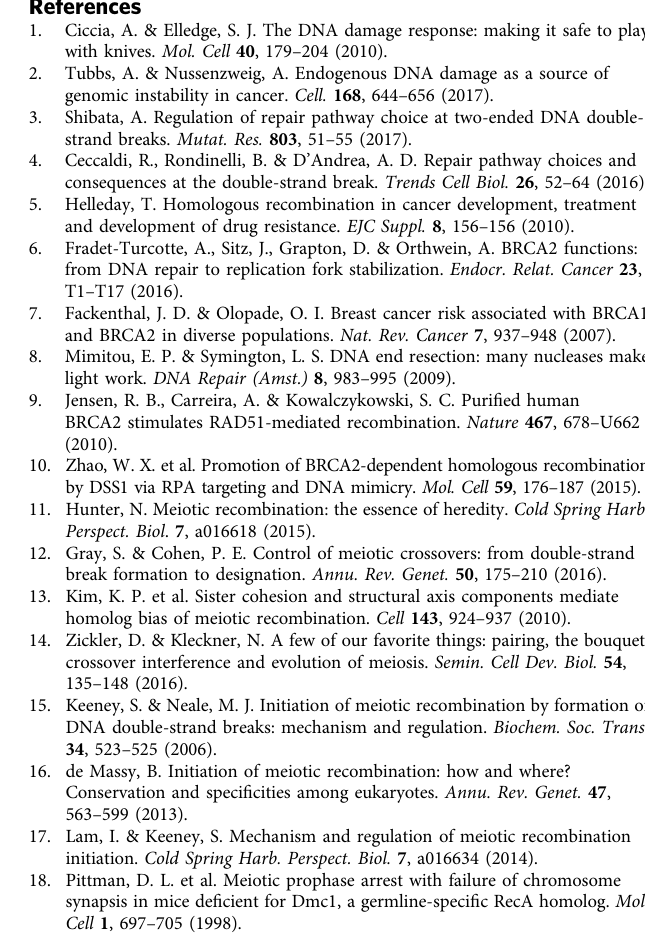
Fig. 6 BRCA2 localization during meiotic prophase I. a , b Wild-type (WT) spermatocytes expressing GFP-BRCA2-C ( a ) or GFP-BRCA2-MBD ( b ) stained with the indicated antibodies and 4,6-diamidino-2-phenylindole (DAPI). c WT zygotene spermatocytes expressing GFP-BRCA2-MBD stained with the indicated antibodies and DAPI. The quanti fi cation of co-localization was performed using nine zygotene cells pooled from three electroporated mice. The axis-associated foci were counted. d , e Zygotene spermatocytes from WT, Meilb2 − ⁄ − , and Dmc1 − ⁄ − males expressing GFP-BRCA2-C ( d ) or GFP-BRCA2- MBD ( e ) stained with the indicated antibodies and DAPI. The graph shows the frequency of the green fl uorescent protein (GFP)-positive zygotene spermatocytes with punctate GFP foci. The mean values of three independent experiments from three different electroporated mice are shown (GFP- BRCA2-C: 63 cells in WT, 57 cells in Meilb2 − ⁄ − , and 85 cells in Dmc1 − ⁄ − . GFP-BRCA2-MBD: 51 cells in WT, 53 cells in Meilb2 − ⁄ − , and 76 cells in Dmc1 − ⁄ − ). Error bars show SD. f Schematic of the hierarchical loading of meiotic double-strand break (DSB)-associating proteins. After DSB formation by SPO11, the double-strand DNA is resected into single-strand DNA (ssDNA). RPA is loaded onto the ssDNA, which is epistatic to the localization of MEILB2. MEILB2 is then recruited to the DSBs, likely through binding to RPA or SPATA22-MEIOB, and this in turn recruits BRCA2 through the MEILB2 – MEILB2-binding domain (MBD) interaction. BRCA2 then facilitates the loading of the RAD51 and DMC1 recombinases onto the ssDNA, resulting in the formation of a nucleoprotein fi lament that promotes DNA strand invasion. Lep leptotene, Zyg zygotene, Pac pachytene, Dip diplotene. All analyses used two-tailed t tests. N.S. not signi fi cant. **** p < 0.0001. Scale bars, 5 and 1 μ m (magni fi ed panel). Source data are provided as a Source Data